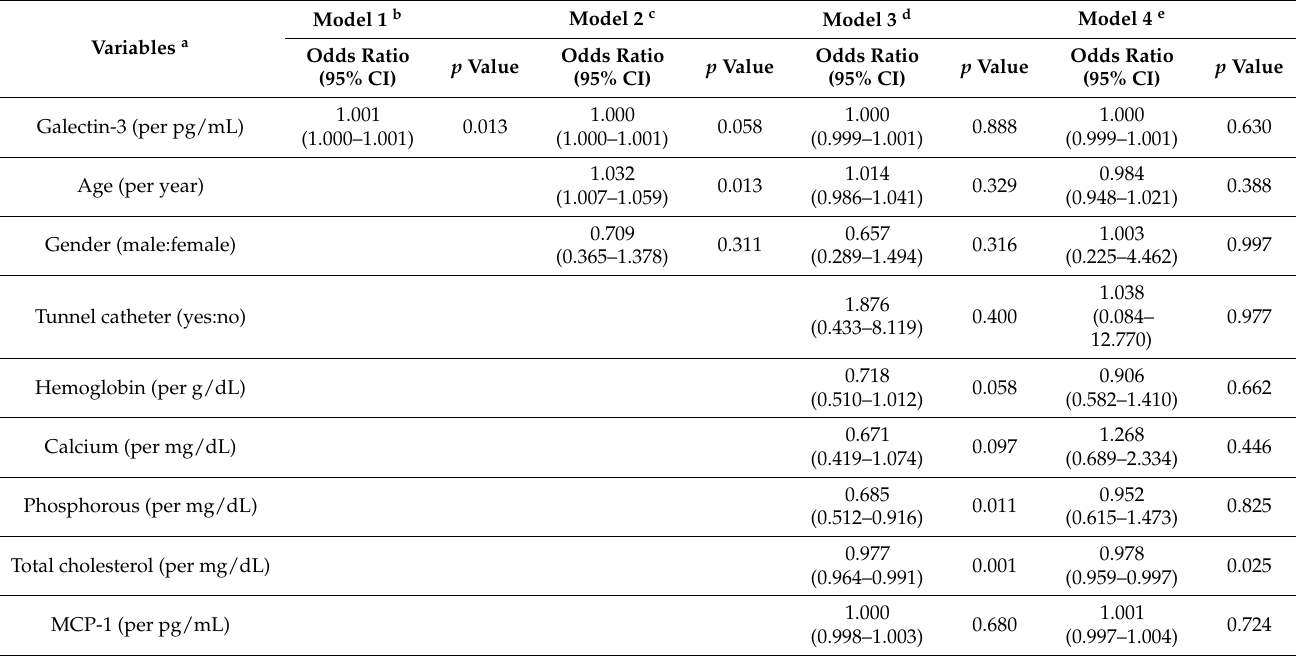
Table 4. Logistic regression analyses of independent variables associated with the presence of PEW as defined by ISRNM criteria in chronic hemodialysis